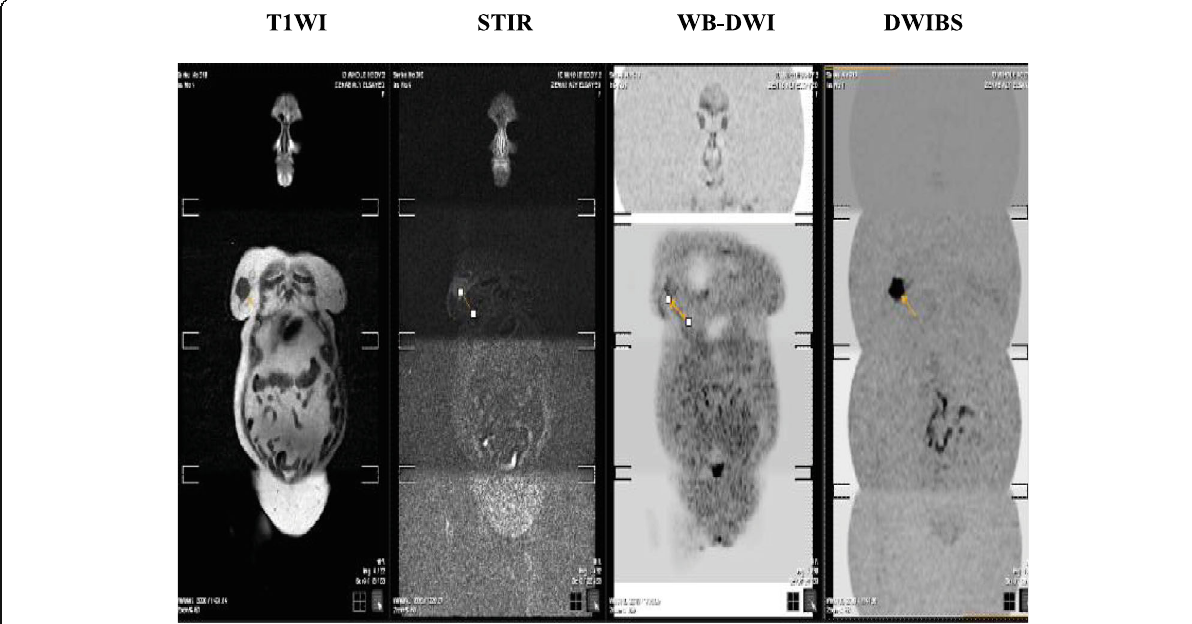
Fig. 4 A 31 year old female diagnosed as invasive duct carcinoma GII Rt. Breast. Rt. breast lesion that is seen in a coronal T1WI, b coronal STIR, and d DWIBS but not seen in c WB-DWI due to inadequate fat suppression. DWIBS examination could detect the breast lesion and denote absence of osseous and soft tissue metastasis, and time of scan was only 15 min